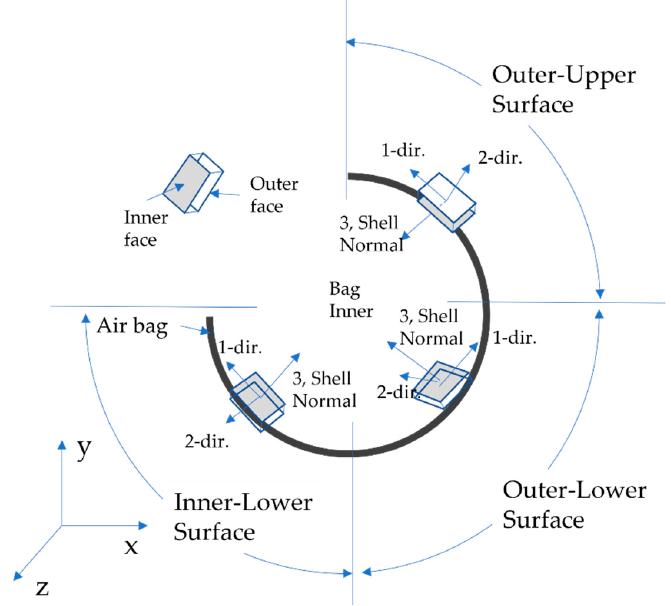
Figure 9. Domain definition of an air bag for variable ply angle setup.